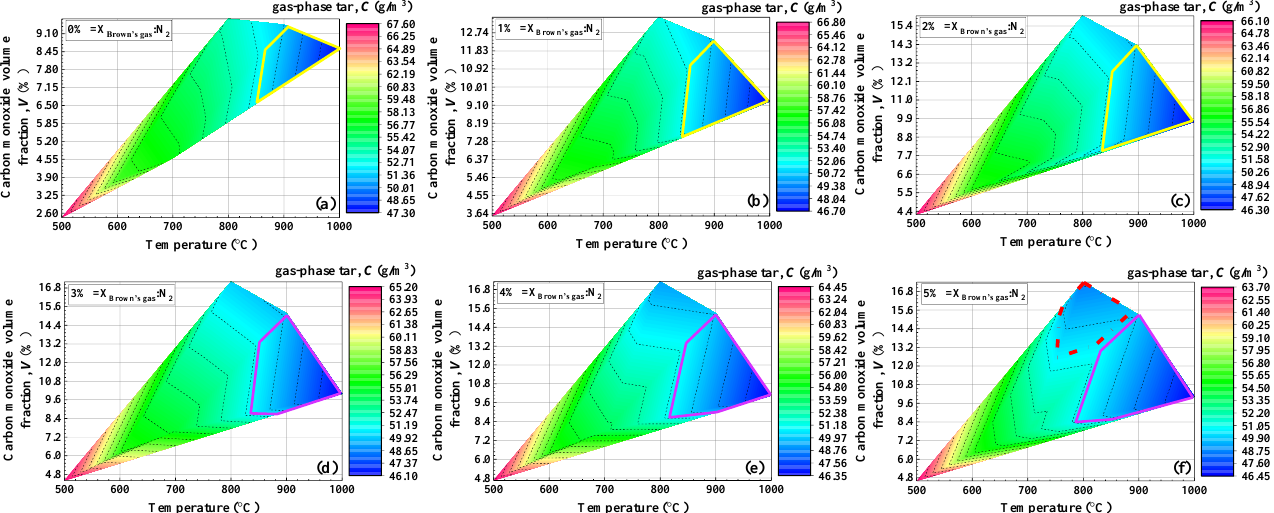
Figure 15. Equilibrium relationship between the flow volume ratio of Brown’s gas to nitrogen, gas- phase tar content, gaseous product temperature, and CO volume fraction. ( a ) X Brown’s Gas: N 2 = 0%, ( b ) X Brown’s Gas: N 2 = 10%, ( c ) X Brown’s Gas: N 2 = 20%, ( d ) X Brown’s Gas: N 2 = 30%, ( e ) X Brown’s Gas: N 2 =